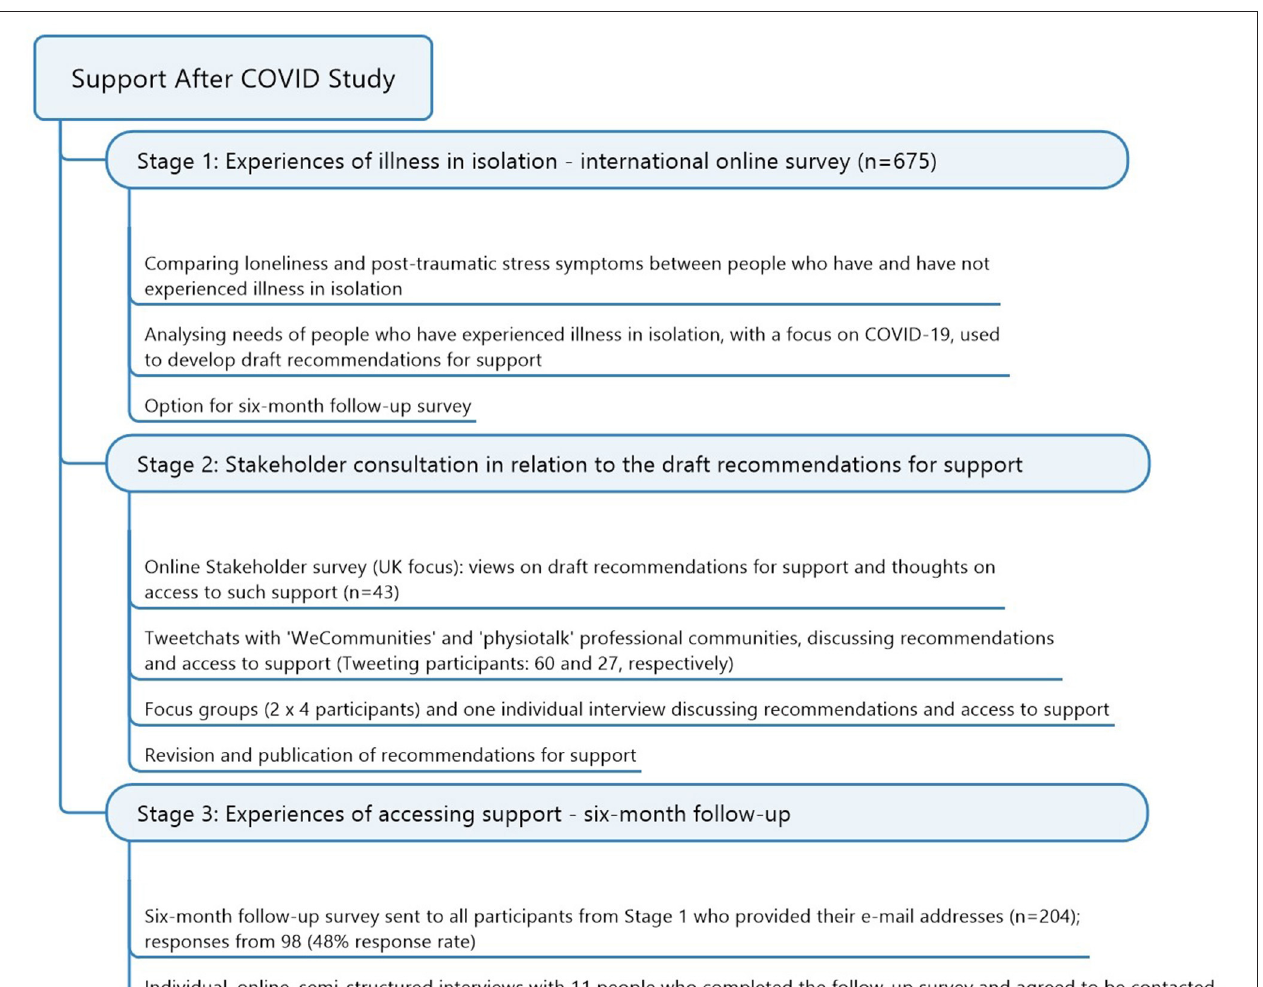
FIGURE 2 | Summary of all stages of the multi-stage “Support After Covid